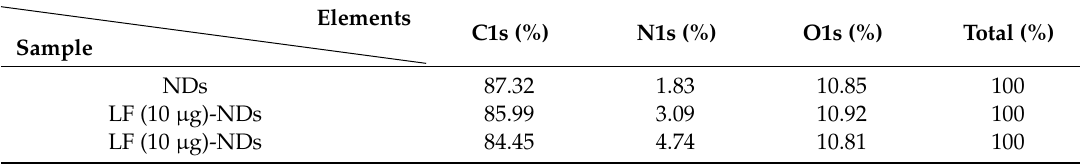
Table 1. Surface elemental composition of NDs, LF (10 µ g)-NDs, and LF (50 µ g)-NDs.